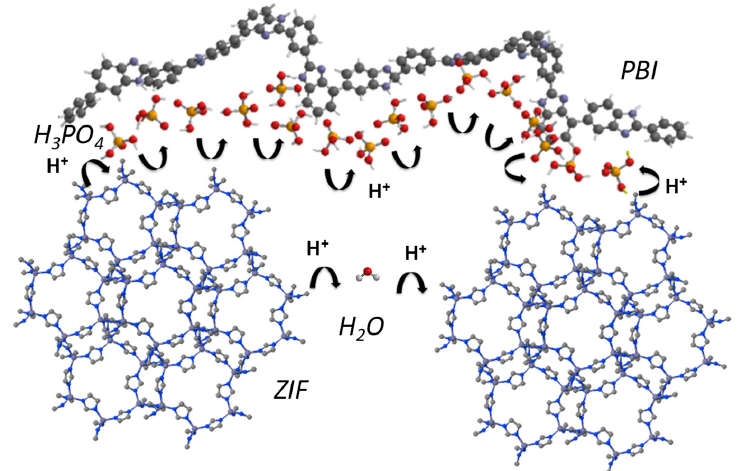
Figure 8. Schematic illustration of the possible mechanism for proton transfer in zeolitic imidazolate framework (ZIF)-containing PBI composite membranes. C, N, O, and P atoms are represented as grey, blue, red, and orange, respectively. H atoms are omitted from the ZIF structure for clarity [77].